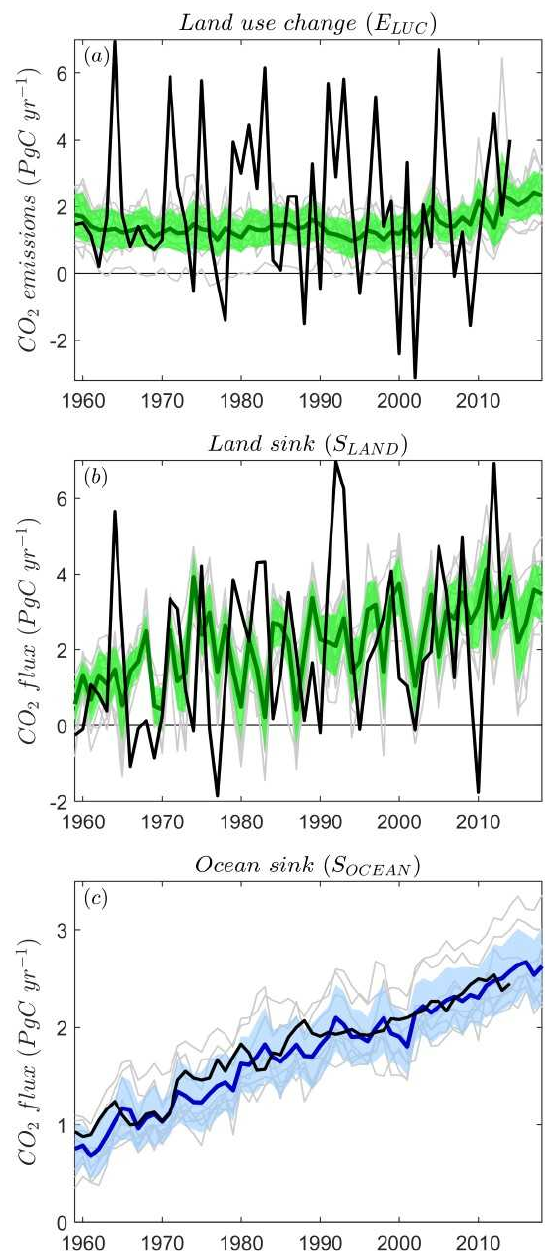
Figure 23. CO 2 exchanges between the atmosphere and the terres- trial biosphere for (a) CO 2 emissions from land use change (ELUC) and (b) land CO 2 sink (SLAND) with individual DGVMs (gray), the multi-model mean (dark green), and its range ( ± 1 σ , light green shading) from GCP overlaid with EC-Earth3-Veg fluxes (black). Panel (c) shows the CO 2 exchange between the atmosphere and ocean (SOCEAN) with individual ocean models (gray), the multi- model mean (dark blue), and its range ( ± 1 σ , light blue shading) from GCP overlaid with EC-Earth3-CC fluxes